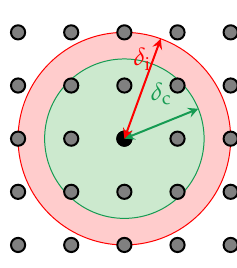
Figure 17. The UDG model used in the simulator. The green circle of radius δ c models the communi- cation range, while the red circle of radius δ i models the interference range.